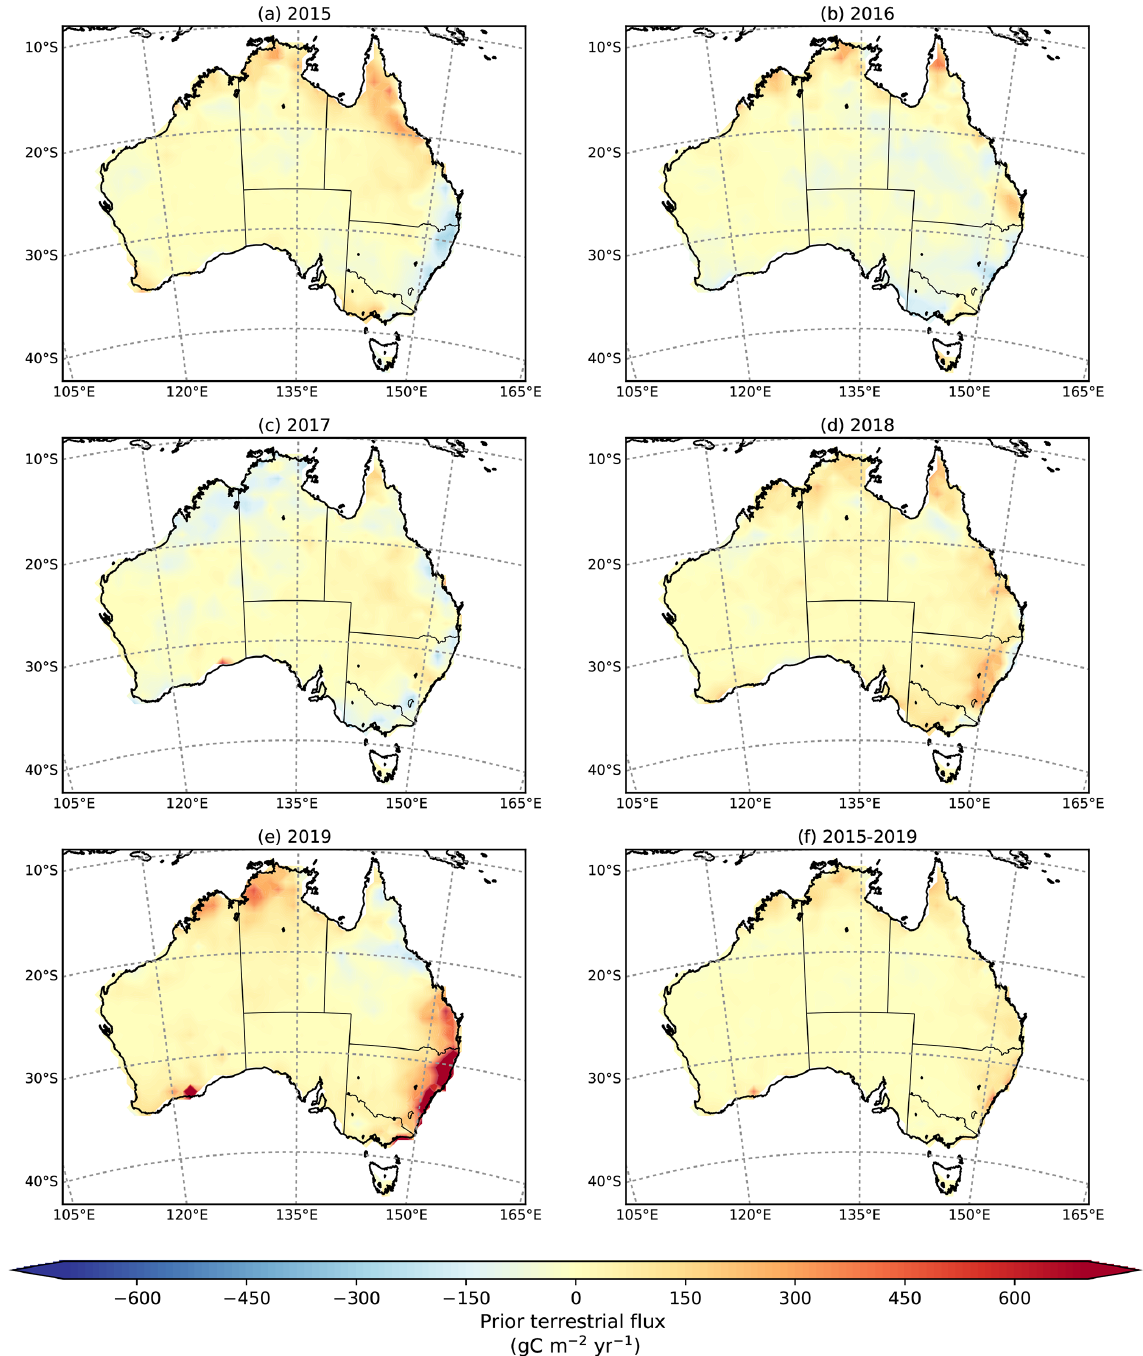
Figure B2. Prior fluxes derived by the CABLE model using the BIOS3 set-up in combination with fire emissions selected by GFED averaged for 2015–2019 (fossil fuel emissions are